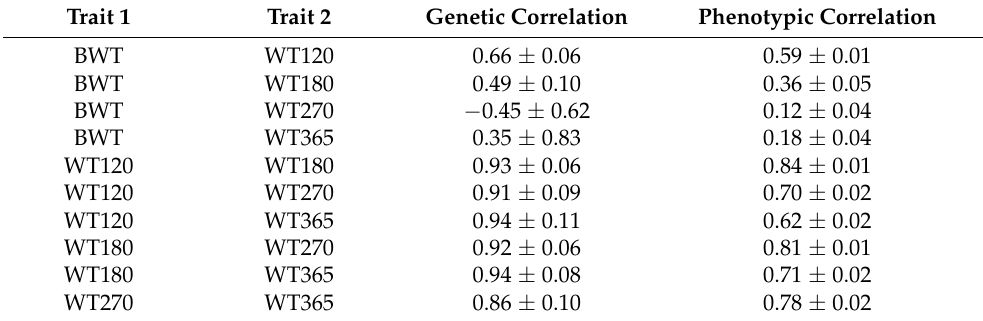
Table 6. Estimates of the genetic and phenotypic correlations between growth traits of Lohi sheep. Trait 1 Trait 2 Genetic Correlation Phenotypic Correlation BWT WT120 0.66 ± 0.06 0.59 ± 0.01 0.49 ±